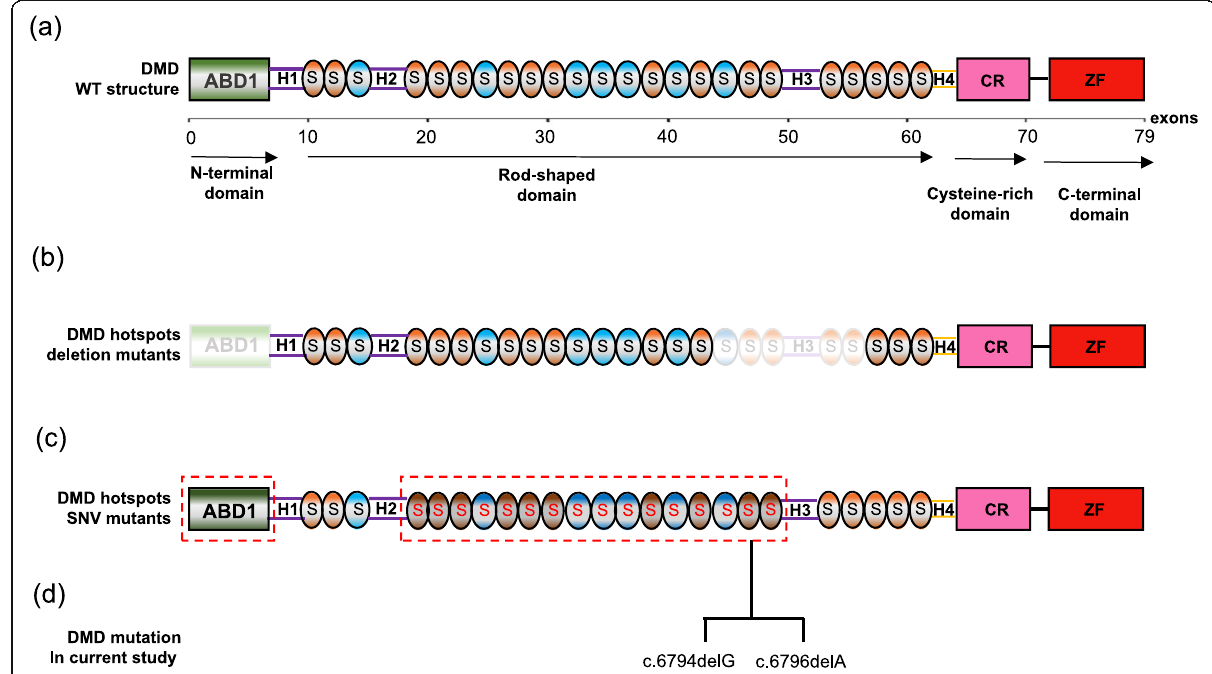
Fig. 5 Overview of the functional domains in the Dystrophin protein and the mutation hotspots. a In normal condition, the full-length protein product is encoded by 79 exons and consists of four domains: N-terminal domain (ABD, green), internal rod-shaped domain (S, orange), cysteine- rich domain (CR, pink) and Zinc Finger-rich carboxyl-terminal domain (ZF, red). b The dystrophin deletion hotspot regions, in which the N terminal ABD and 45 – 55 exons in the central rod-like domain are gray. c SNV hotspot mutation regions are highlighted in red circle. d The mutants discovered in our study are also